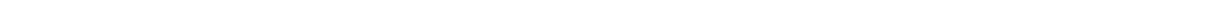
Fig. 4 Regulation of senescence by TGF- β signaling is dependent on miR-29-induced inhibition of H4K20me3. a Western blot for the indicated proteins in MEFs grown in 3% oxygen or 20% oxygen. β -actin served as a loading control. b , c RT-qPCR analysis of miR-29 expression in the cells from a . d Western blot to assess total H4K20 methylation in serially passaged MEFs grown in 3% oxygen or 20% oxygen. β -actin served as a loading control. e MEFs grown in 3% oxygen and transferred to 20% oxygen (left) or MEFs grown in 20% oxygen and transferred to 3% oxygen (right) were treated with or without inhibitors. Protein changes were tested by western blot. H4 and β -actin served as loading controls. f Western blots showing altered H4K20 methylation in MEFs incubated with or without inhibitors upon knockdown of shCtrl, Suv4-20h1, Suv4-20h2 or both. g SA- β -gal staining showing alterations in the SA- β - gal signal in the cells from f . Scale bar, 20 μ m. One-way ANOVA with Dunnett ’ s multiple comparison test analysis was performed. h Immuno fl uorescent staining showing the Mki67 signal in MEFs exposed to the same treatment as those shown in f . Scale bar, 5 μ m. i Western blot for analyzing the indicated proteins in MEFs subjected to inhibition of miR-29 expression followed by TGF- β treatment. H4 and β -actin served as loading controls. The error bars represent the s.d. obtained from triplicate independent experiments. Two-tailed unpaired Student ’ s t -tests were performed, ** p < 0.01, *** p <